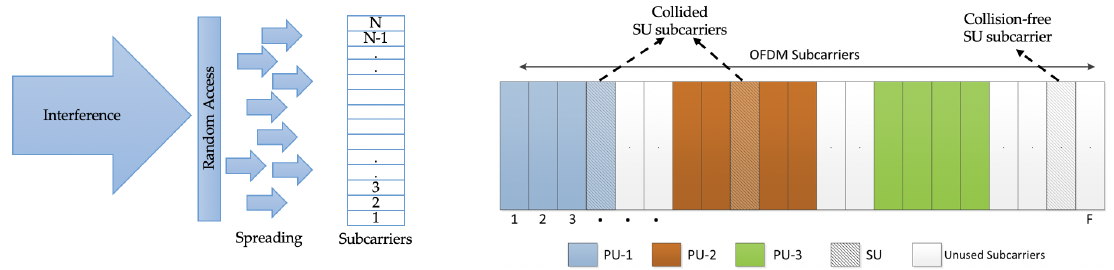
Figure 1. Interference spreading in an OFDM-based cognitive radio network showing subcarrier collisions and no subcarrier